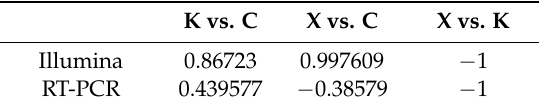
Table 5. Pearson correlation to corroborated with DEGs and Real-time